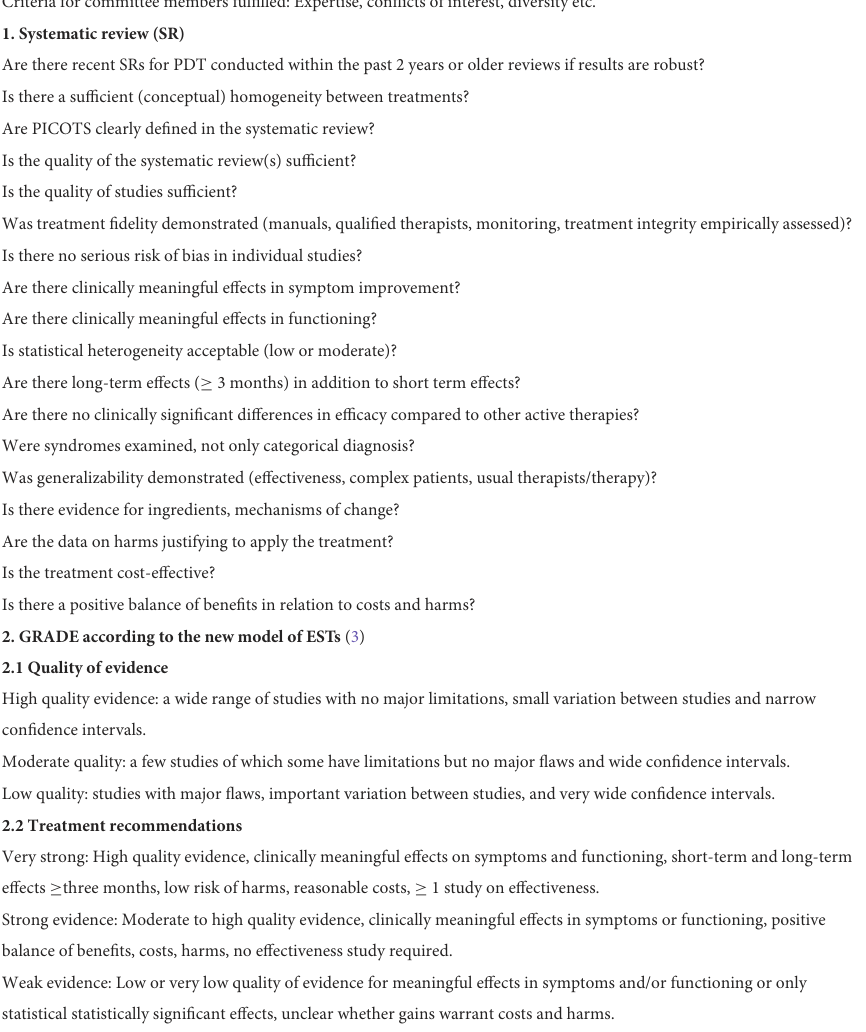
TABLE 1 Checklist for updated criteria of empirically supported treatments (3). Mental